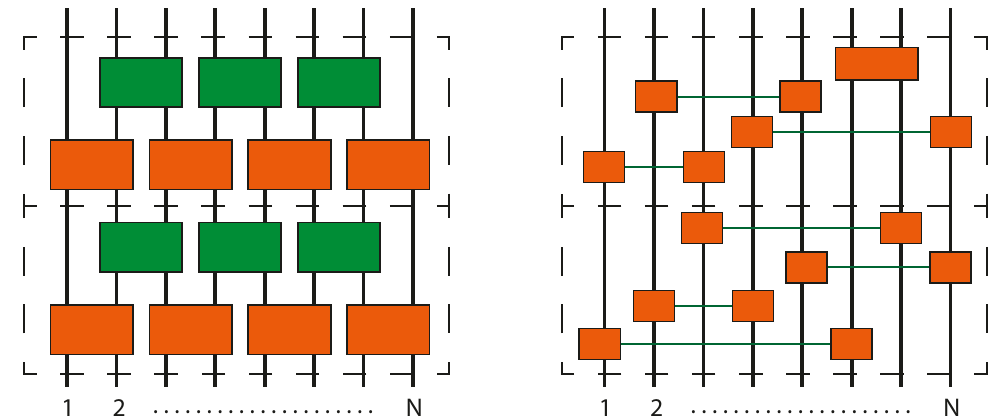
Figure 16 . [Left] Local random circuit evolution on N qubits, each gate is randomly selected from a gateset (cid:0) 2 U(4). [Right] 2-local random circuit on N qubits, in each step qubits are randomly paired and random gate is applied from a gateset